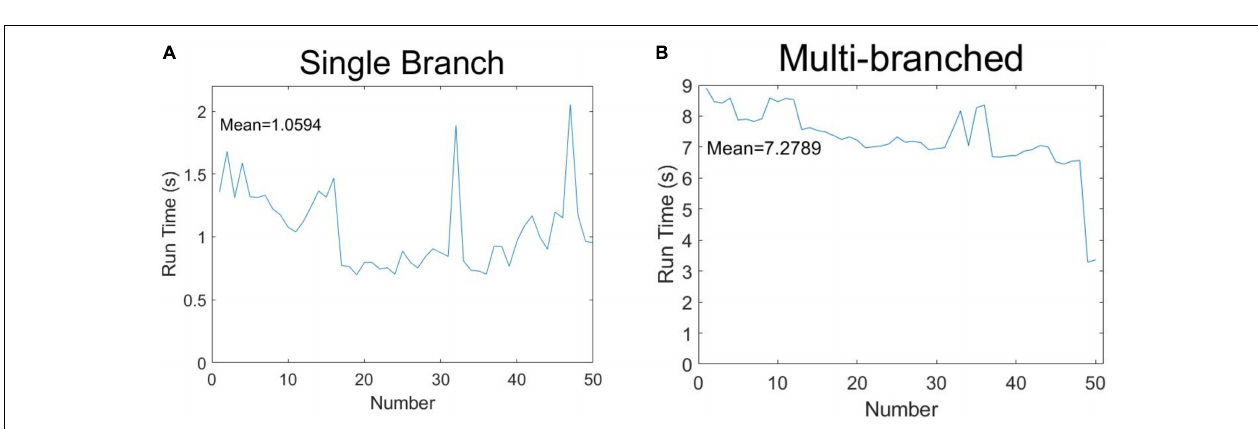
FIGURE 12 | Speculation time of soybean phenotype acquisition: (A) single-branch soybean plants and (B) multi-branched soybean plants.